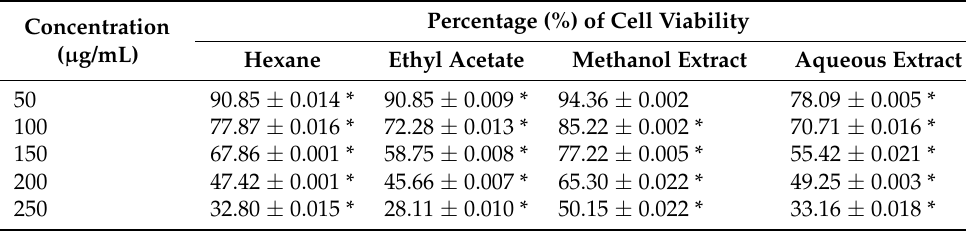
Table 3. Anticancer activity of F. arabica extracts against lung cancer A549 cell line. Concentration in µ g/mL